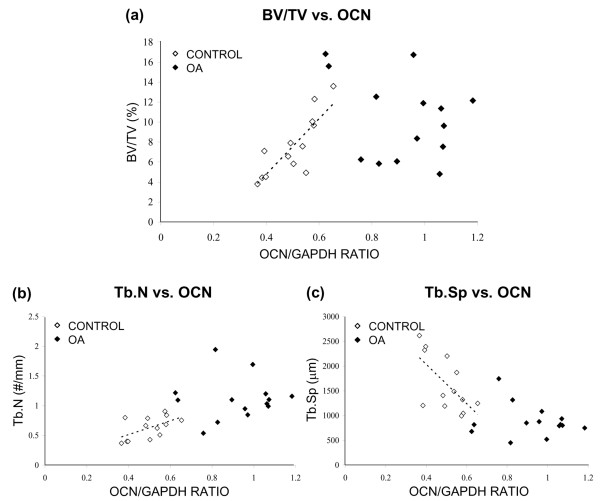
Associations between osteocalcin (OCN)/GAPDH mRNA and the histomorphometric parameters of bone tissue volume (BV/TV), trabecular number (Tb.N), and trabecular separation (Tb.Sp). The relative OCN/GAPDH mRNA expression and architectural parameters were determined in intertrochanteric trabecular bone from osteoarthritis (OA) (n = 14) and control (n = 13) individuals. (a) In controls, there was a significant increase in BV/TV with increasing OCN/GAPDH mRNA (BV/TV = 27.7 [OCN/GAPDH] – 6.3; r = 0.82, p < 0.0007) in contrast to the patients with OA (BV/TV = -7.57 [OCN/GAPDH] + 17.38; r = -0.31, p = not significant [NS]). (b) A significant increase in Tb.N with increasing OCN/GAPDH mRNA was observed in controls (Tb.N = 1.16 [OCN/GAPDH] + 0.05; r = 0.56, p < 0.05). In OA, there was no significant association between Tb.N and OCN/GAPDH mRNA (Tb.N = 0.09 [OCN/GAPDH] + 1.03; r = 0.04, p = NS). (c) In controls, there was a significant decline in Tb.Sp with increasing OCN/GAPDH mRNA (Tb.Sp = -3,977.9 [OCN/GAPDH] + 3,626.1; r = -0.64, p < 0.02) and no significant change in Tb.Sp with OCN/GAPDH mRNA in OA individuals (Tb.Sp = -353.5 [OCN/GAPDH] + 1,214.4; r = -0.19, p = NS). GAPDH, glyceraldehyde-3-phosphate dehydrogenase.